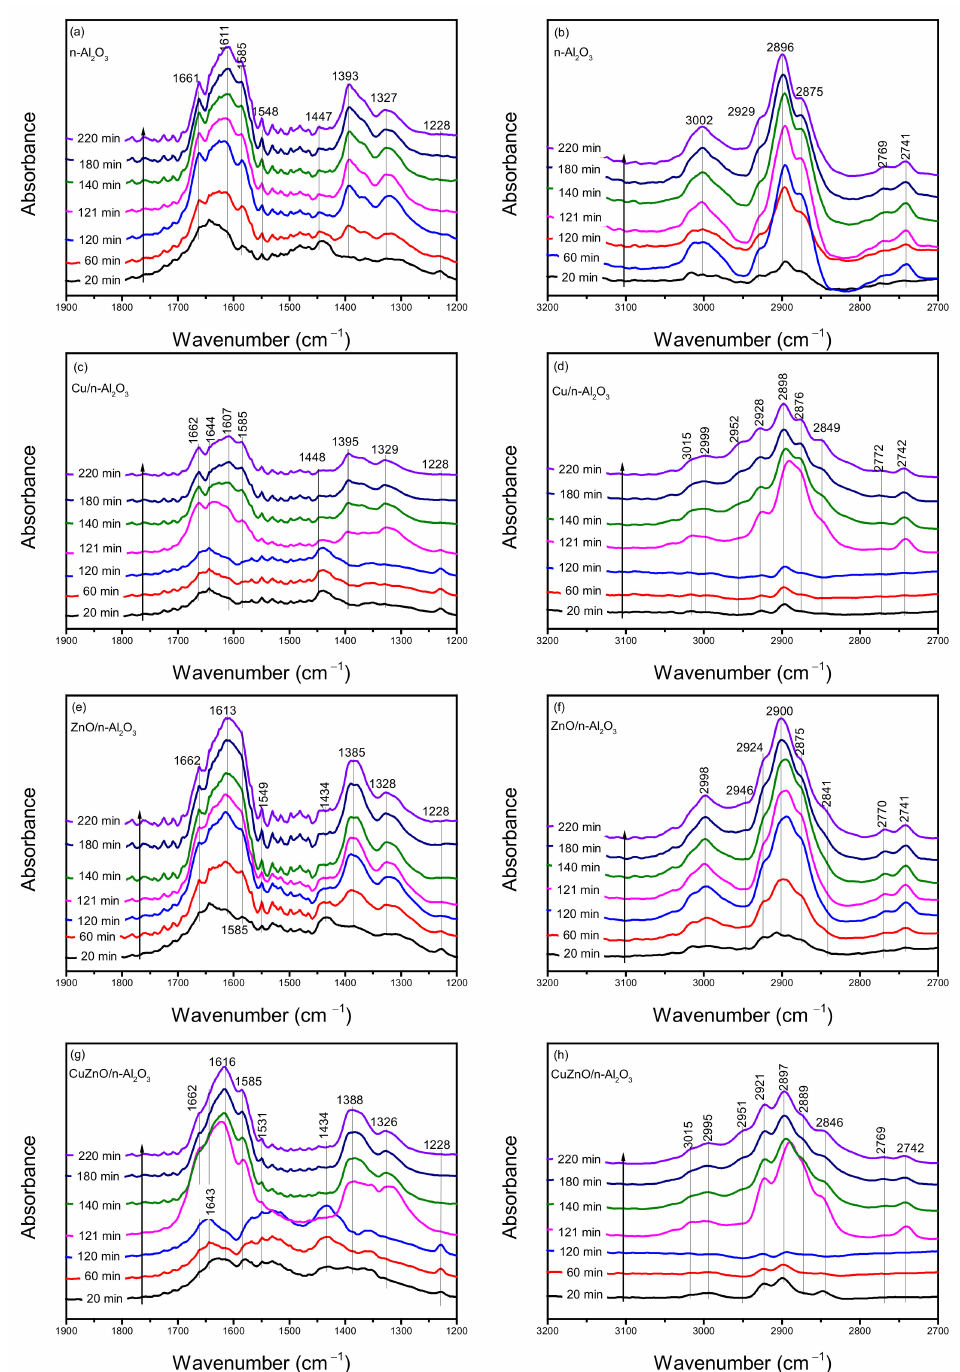
Figure 6. In situ DRIFT spectra at different times for the fresh catalysts (reduced in H 2 at 300 ◦ C, purged in N 2 , and then switched to CO 2 gas): ( a , b ) n-Al 2 O 3 , ( c , d ) 3% Cu/n-Al 2 O 3 , ( e , f ) 3% ZnO/n- Al 2 O 3 , and ( g , h ) 3% CuZnO/n-Al 2 O 3 at 250 ◦ C under 2 MPa for both pure CO 2 gas (0–120 min) and after switching the feed gas to H 2 (120–220